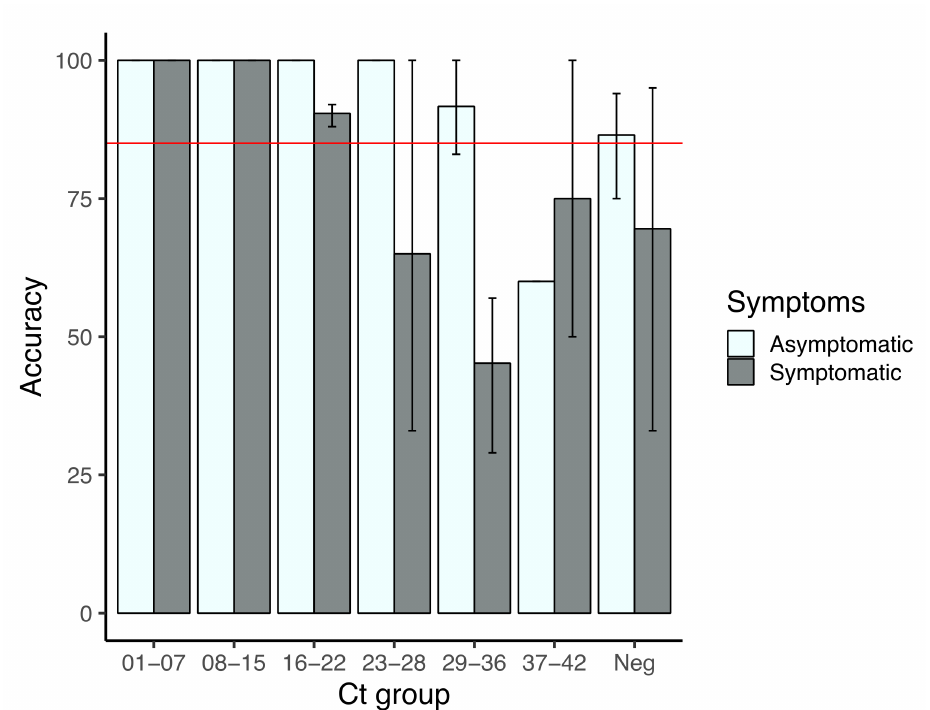
Figure 4. Performance of the application-mediated detection among symptomatic and asymptomatic patients. Accuracy = tp + tn/total of symptomatic or asymptomatic in each Ct group; standard deviation was established based in the calculated accuracy per type of sample in each group. The red line marks a 85% of accuracy, required in Colombia for SARS-CoV-2 diagnostic